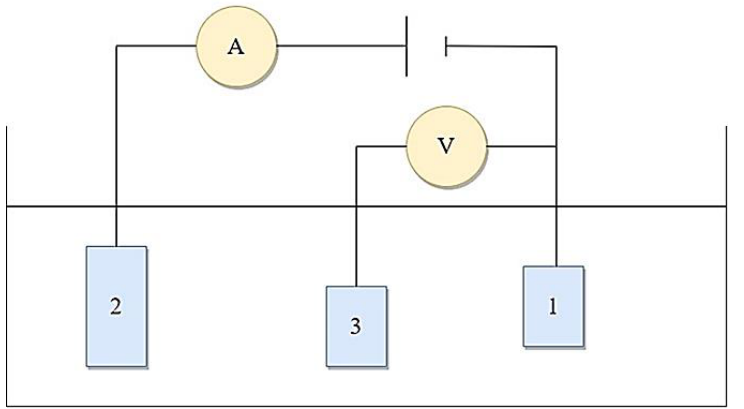
Figure 2. Schematical representation of an electrochemical cell equipped with three electrodes. As represented in Figure 1, the three factors should be evaluated. Hence, for me- chanical wear, the classical investigation is achieved by a classical tribometer, whereas for chemical wear, several techniques should be adopted according to the aim of the in- vestigation [6], involving two or three electrodes. The first and the simplest is the